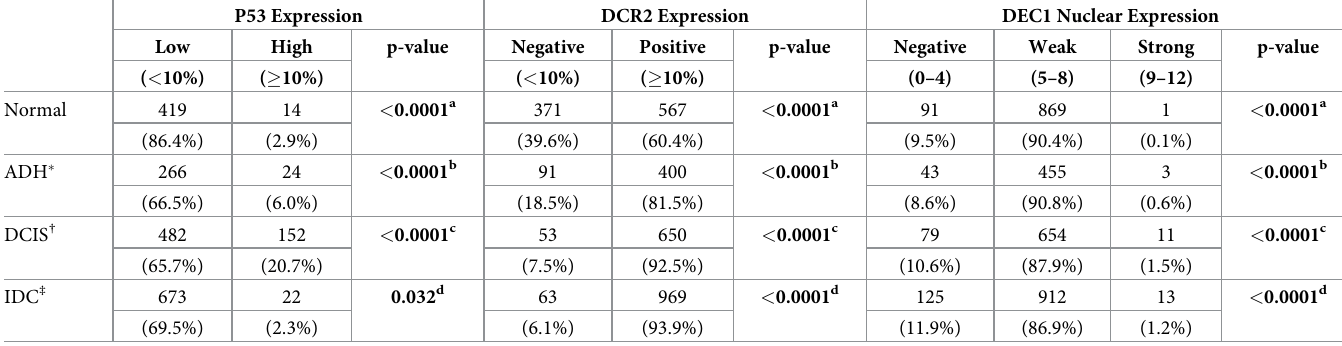
Table 1. Association of protein expression with breast cancer